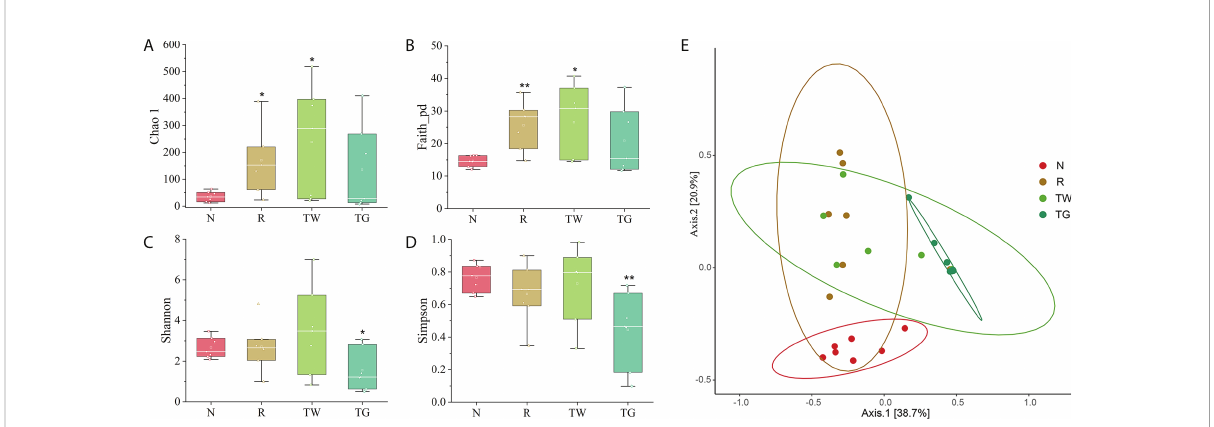
FIGURE 1 Effects of QWBZP-TG on the microbial diversity in AAD mice. (A) Chao 1, (B) Faith_pd, (C) Shannon, and (D) Simpson are the alpha diversity indices. (E) Principal coordinate analysis (PCoA) plot of the microbiota in the small intestine in the four groups (beta diversity). N, normal control group; R, antibiotic-associated diarrhea (AAD) restore group; TW, Qiwei Baizhu Powder (QWBZP) decoction group; TG, total glycosides of Qiwei Baizhu Powder (QWBZP-TG) group. Data are expressed as mean ± standard deviation (SD), n = 7. * P < 0.05 and ** P < 0.01 compared with the N